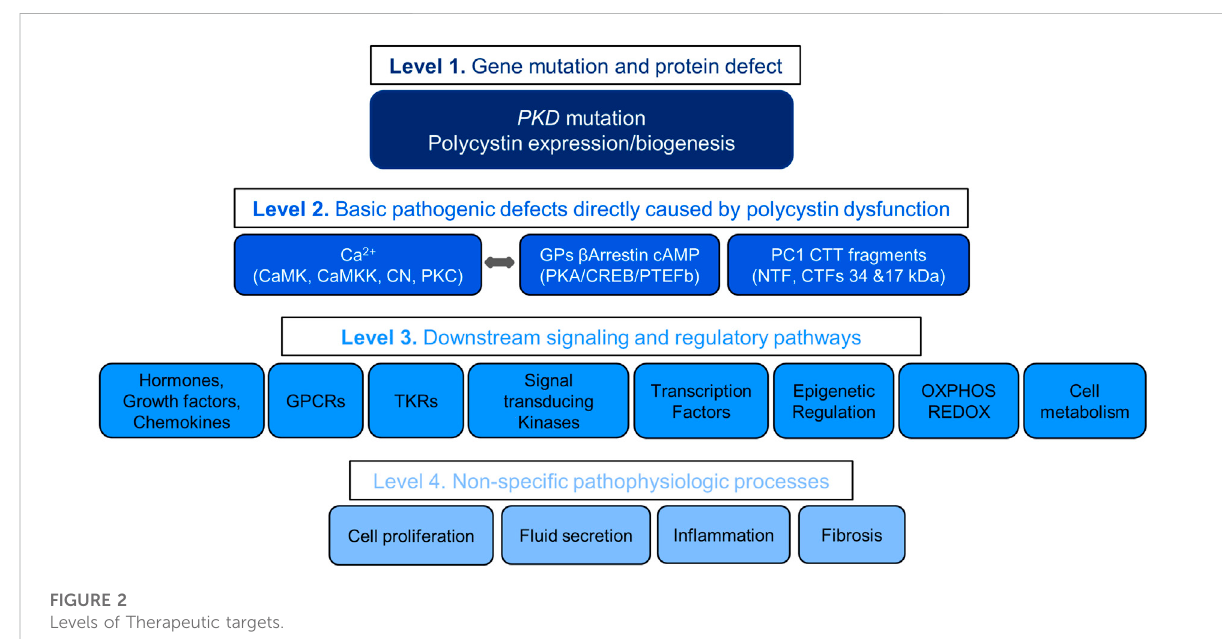
FIGURE 2 Levels of Therapeutic